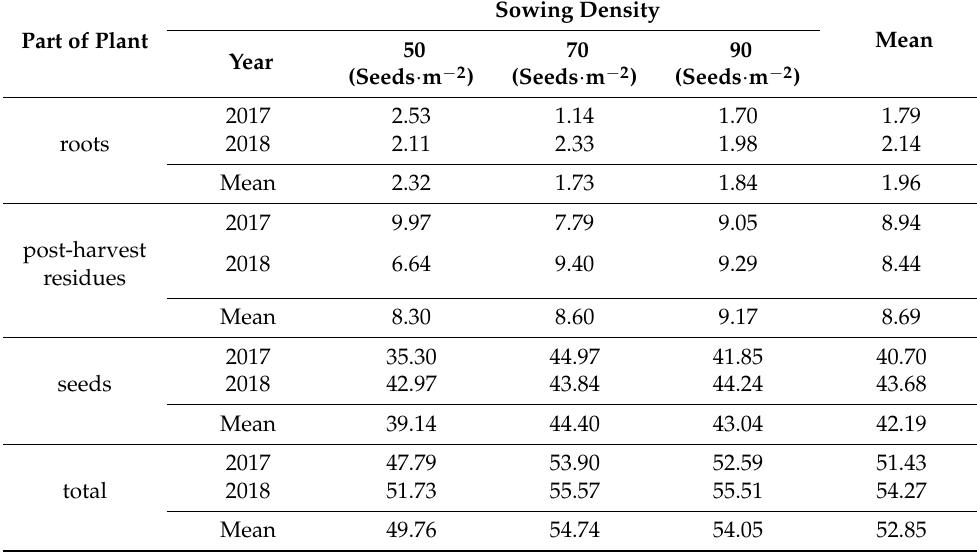
Table 7. Nitrogen amount taken up by soybean from soil, kg N · ha − 1